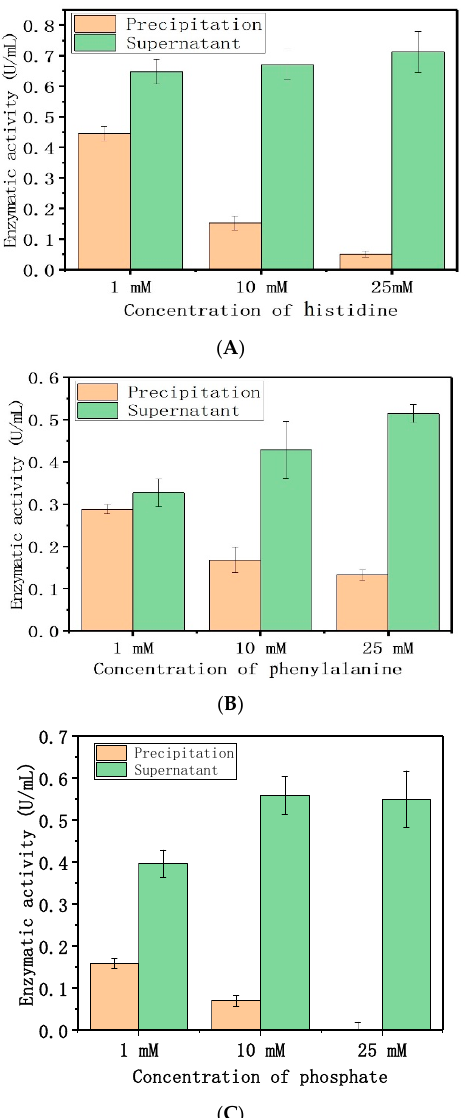
Figure 4. Effect of different concentrations of amino acids and phosphate on adsorption: ( A ) histidine, ( B ) phenylalanine, ( C ) phosphate.